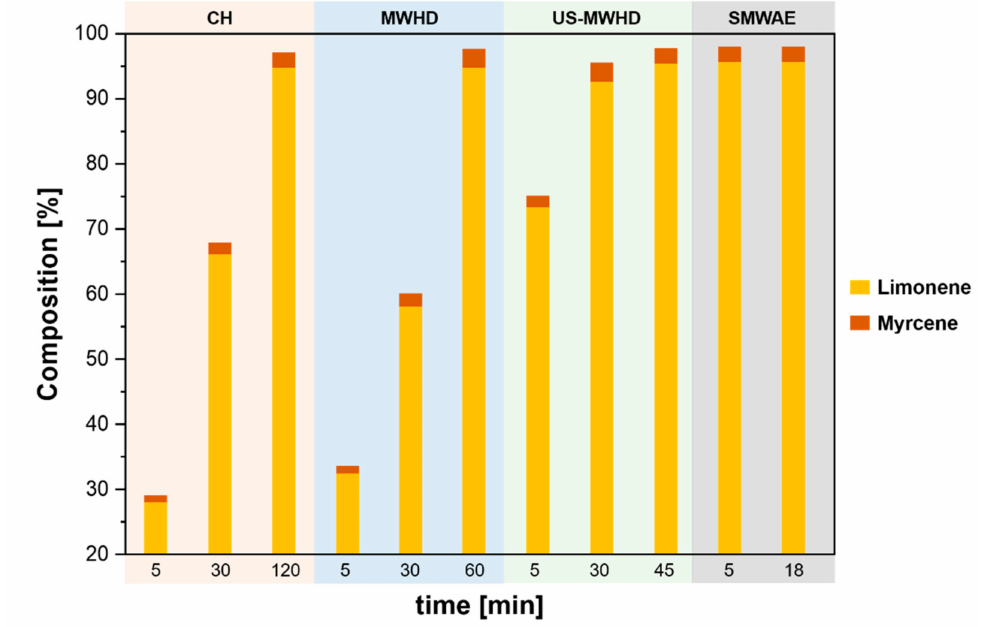
Figure 4. Chemical composition of the orange peel essential oils (Eos) obtained by conventional hydrodistillation (CH), solvent-free, microwave-assisted extraction (SMWAE), ultrasonic and mi- crowave irradiation hydrodistillation (US–MWHD) and MWHD at different extraction times with a composition higher than 2%. Adapted with permission from Gonz á lez-Rivera et al. [47]. Copyright (2016) Royal Society of